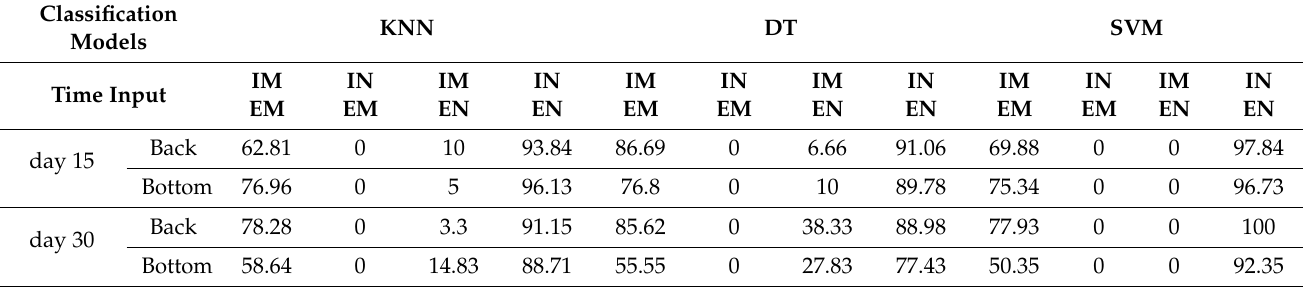
Table 2. CA (%) of different classification models for different mildew